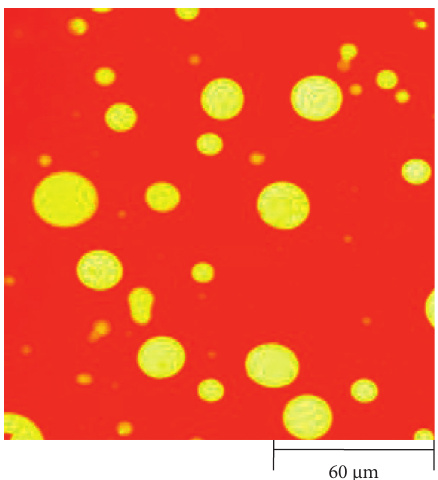
Figure 6: Fluorescence micrographs of undeveloped SBS modified asphalt with 15% content of APR.